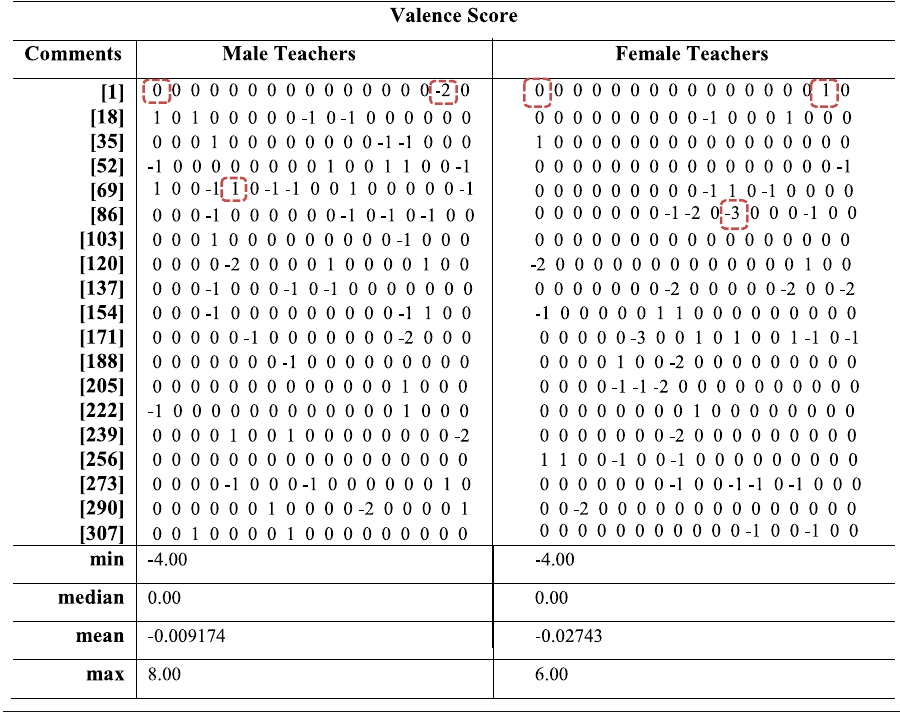
Table 3 Fragment of the valence scores for the teachers by gender